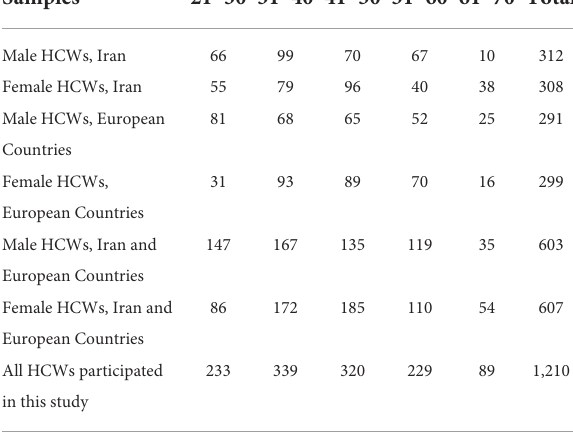
TABLE 1 The number of male and female HCWs, in each age group, who participated in our study in Iran and the European countries.